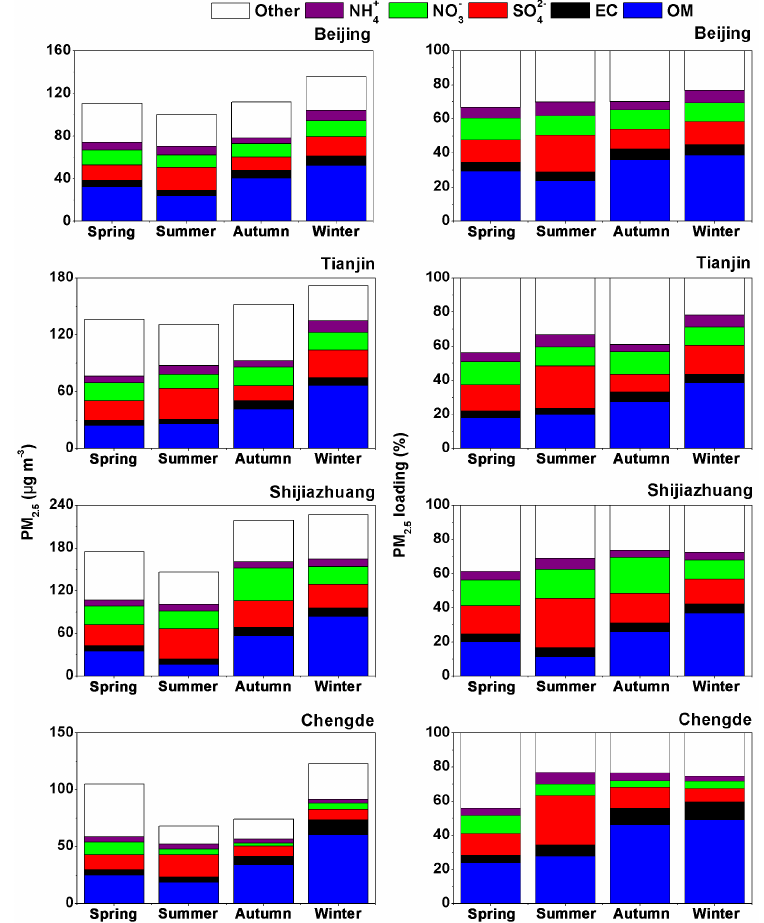
Figure 4. Seasonal PM 2 . 5 and dominant chemical components in